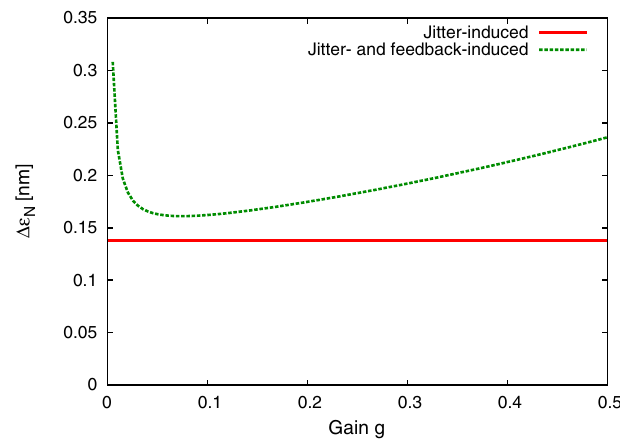
FIG. 4. (Color) Determination of the optimal feedback gain when all dynamic imperfections are considered. The optimum gain is 0.074 leading to a constant emittance growth contribution of 0.161 nm. The jitter effect alone causes an emittance growth of 0.138